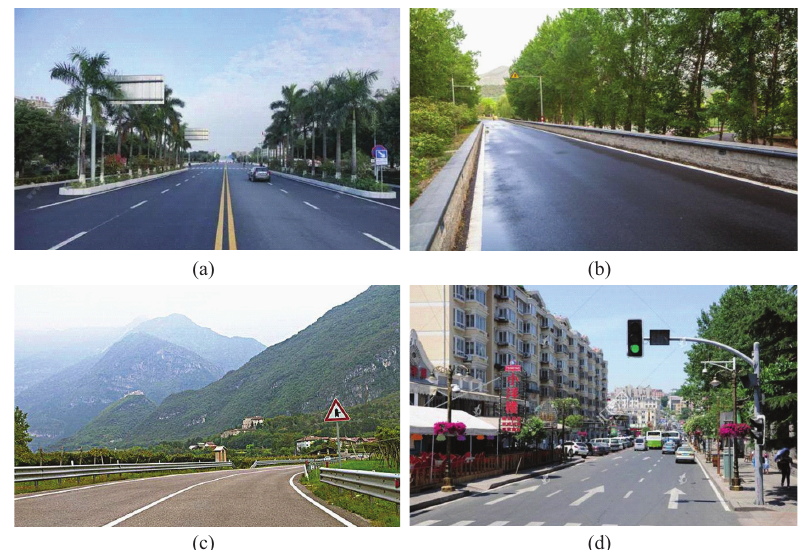
Figure 14. The examples of various scenes: ( a ) urban main road; ( b ) suburban road; ( c ) mountain road; ( d ) city street.